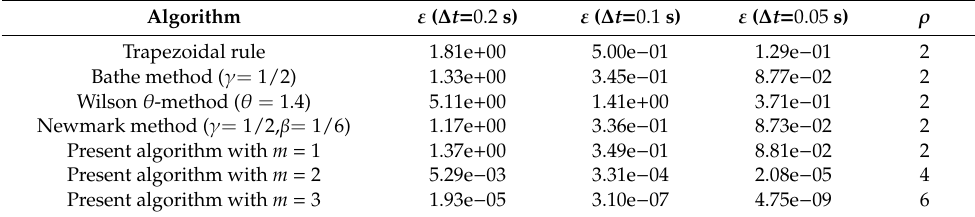
Table 2. Errors of velocity solutions (pendulum) calculated from di ff erent